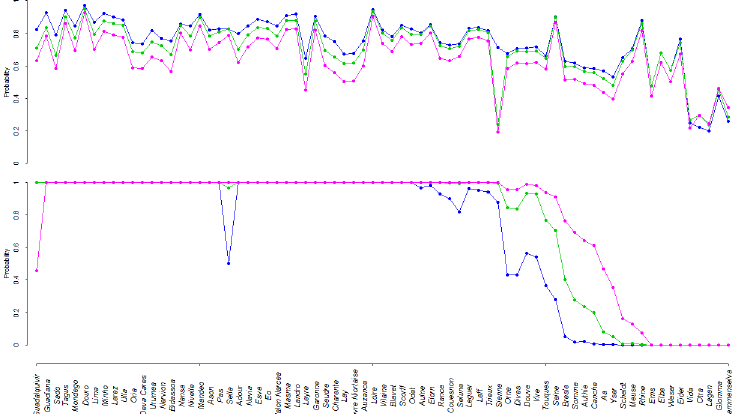
Fig 3. Species distribution models outputs along the latitudinal gradient from southern Spain to southern Scandinavia. (a) The upper panel represented outputs of the correlative SDM and (b) the lower panel the outputs of the mechanistic SMD. Blue, green and pink circle symbols represented probability outputs for 1901 – 1910, for 2070 – 2100 assuming the RCP 4.5 scenario and for 2070 – 2100 assuming the RCP 8.5 scenario respectively. For the correlative model, probabilities corresponded to the probability for a basin to be suitable at the given time period while for the mechanistic SDM, it represented the probability for a basin to sustain a stable population.